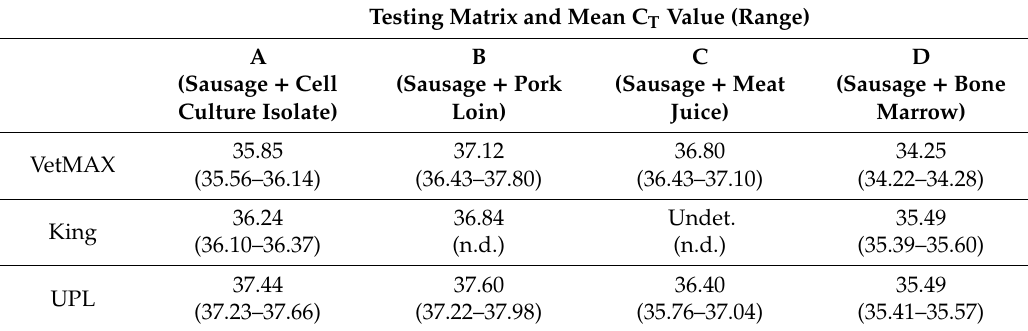
Table 2. C T values obtained in cooked meat products using manual MagMAX